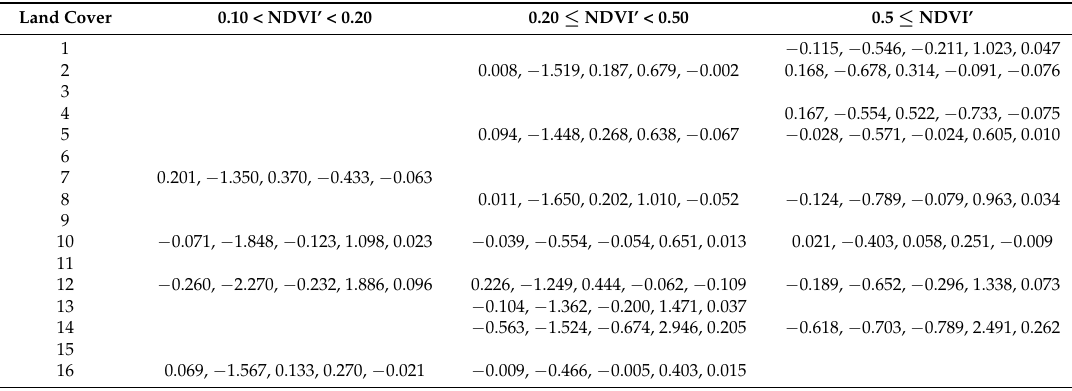
Table 3. Surface Reflectance Coefficients for 0.47 µ m for June-July-August (JJA). Land Cover 0.10 < NDVI’ < 0.20